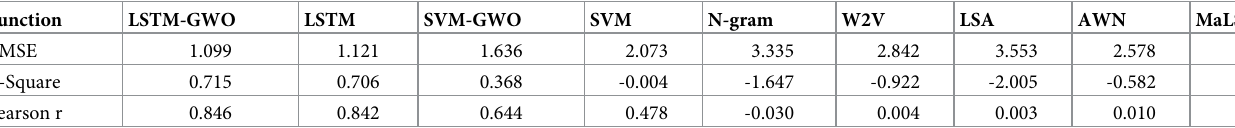
Table 6. Comparison of the proposed model and compared models with experiment 2.